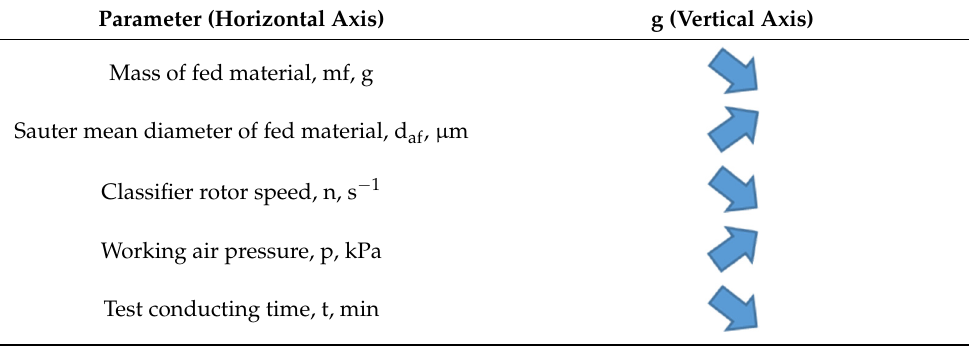
Table 6. Effect of increase in input parameters on performance g of classification process.